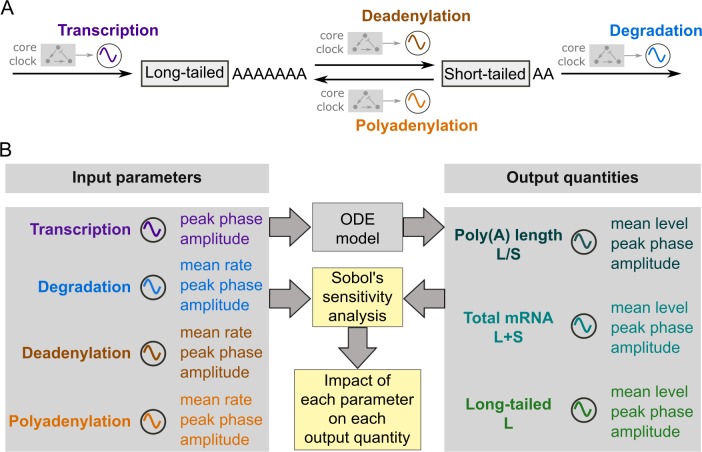
Overview of the study.(A) Schematic diagram of the model. The model describes four processes that control the poly(A) tail length and mRNA abundance: transcription, degradation, cytoplasmic deadenylation and polyadenylation. The rhythmicities of the four processes, i.e., amplitude and phase, are presumably controlled by the core clock mechanism (shaded molecular circuit), which is not explicitly included in the model. (B) Work flow of the study. Numeric simulations of the ODE model using different sets of input parameters (sampled according to Table 1, S1 Fig) generate the output quantities. The input parameters and output quantities are analyzed through the global parameter sensitivity analysis to quantify the impact of each parameter on each output quantity over the global parameter space.